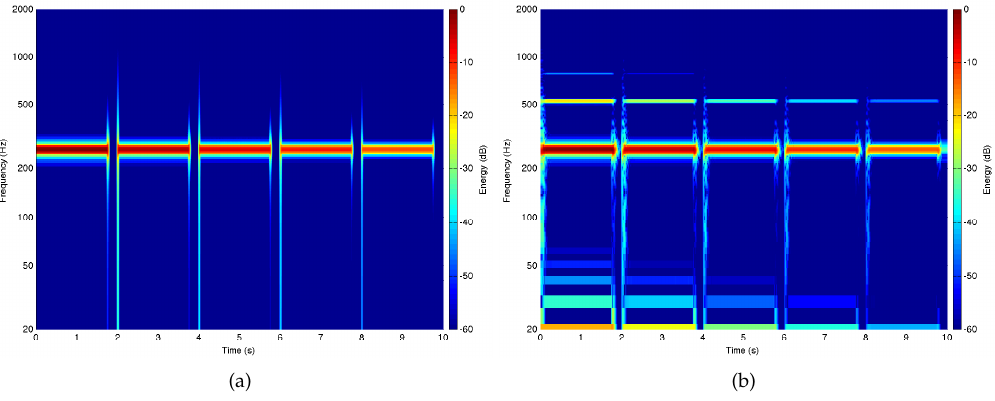
Figure 13. Decreasing amplitude interacting with distortion. ( a ) C3 input signal, various amplitudes; ( b )